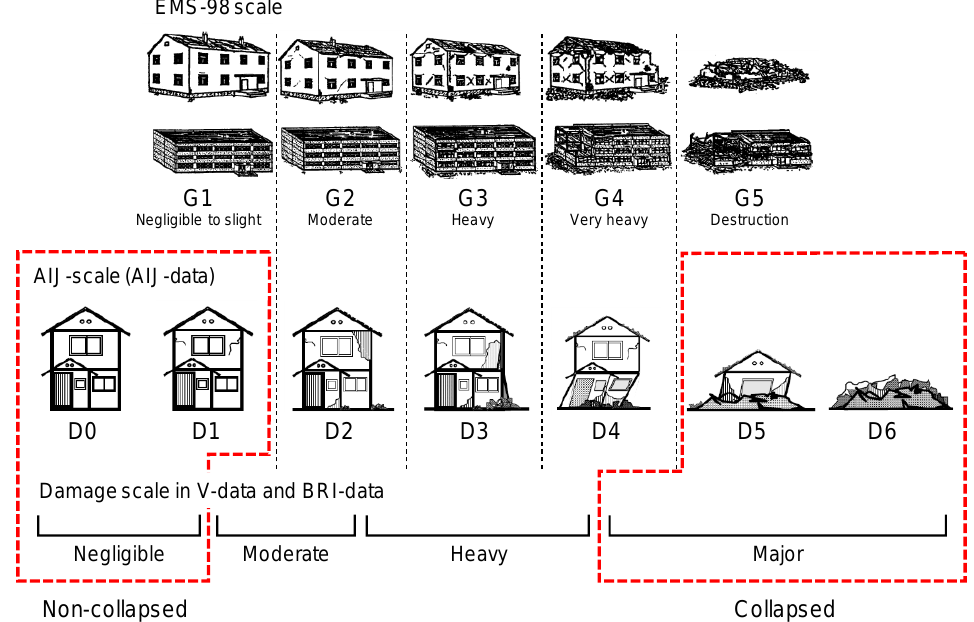
Figure 2. Comparison of the building damage scales of the Architectural Institute of Japan (AIJ)-scale [31], the European Macroseismic Scale (EMS-98) [32] and the damage scale in the V (visual interpretation)-data [34] and the Building Research Institute of Japan (BRI)-data [35]. D0, D1 and the negligible damage levels are classified into non-collapse, and D5, D6 and the major damage levels are classified into collapse in this study. Table 1. Descriptions of the building damage in EMS-98, AIJ-scale, V-data and BRI-data defined in the literature [31,32,34,35].